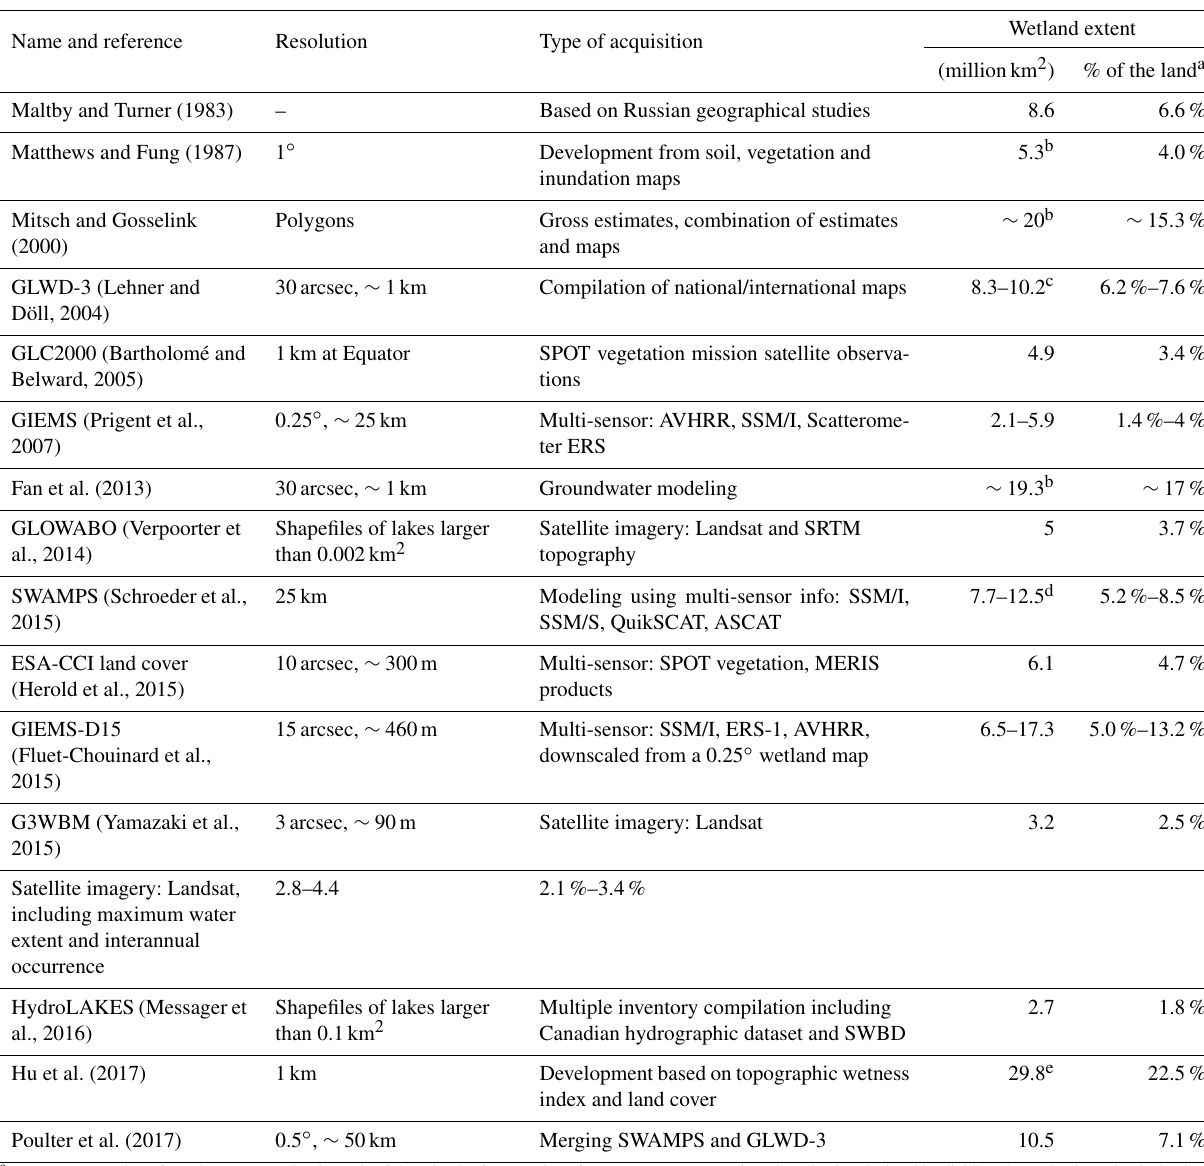
Table 1. Summary of water body, wetland and related proxy maps and datasets from the literature. The wet fractions indicated in % in the last column are those indicated in the reference paper or data description for each